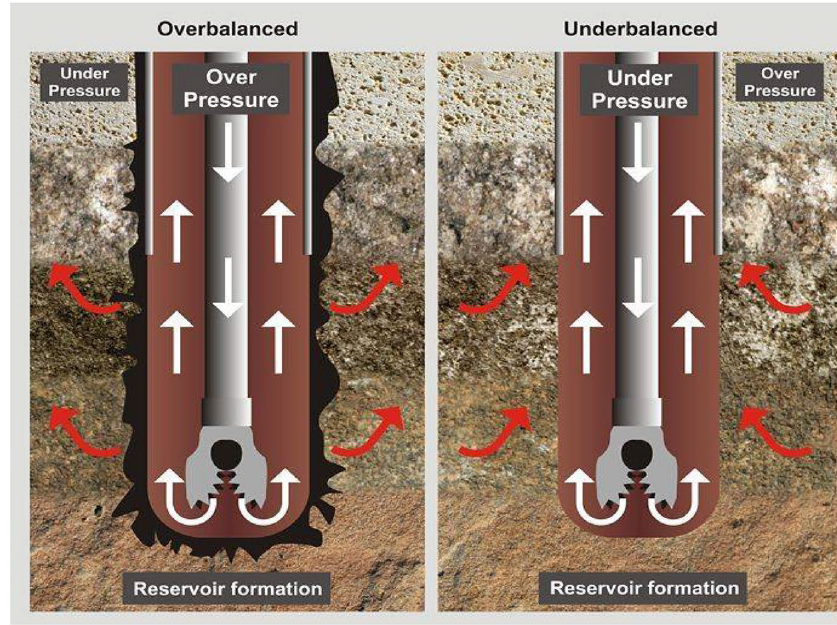
Fig. 4 Types of drilling tech- niques (copied with permission from http://www.oilfi elden ginee r.com)